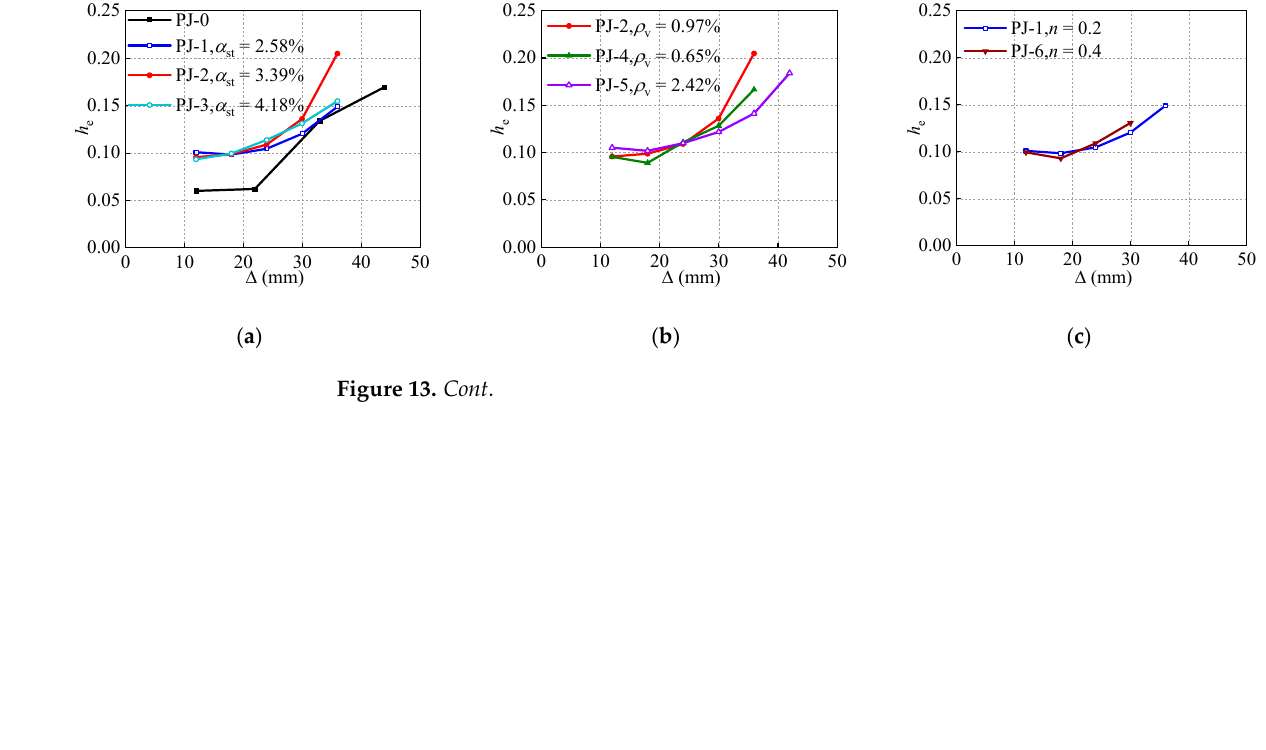
is not noticeable.